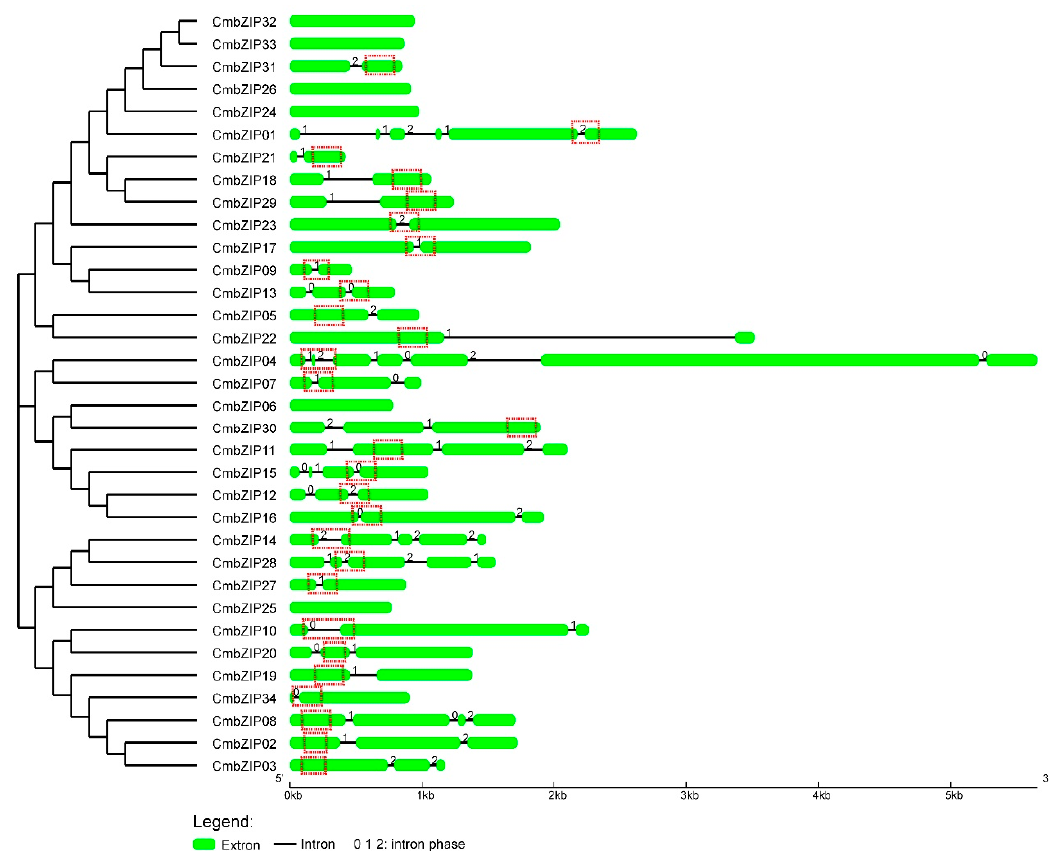
Figure 3. Analysis of gene structures of CmbZIPs. Arrangements of introns and exons are displayed by GSDS version 2.0. Red dotted boxes, representing the bZIP domains of each sequence, are marked manually. Green boxes indicate exons, drawn to scale. Black lines between exons represent introns. The number 0, 1, and 2 represent the splicing phase of intron. Phase 0 means intron splicing site is between codons, and phase 1 and phase 2 means the intron splicing site is located after the first and second nucleotide of a codon, respectively.